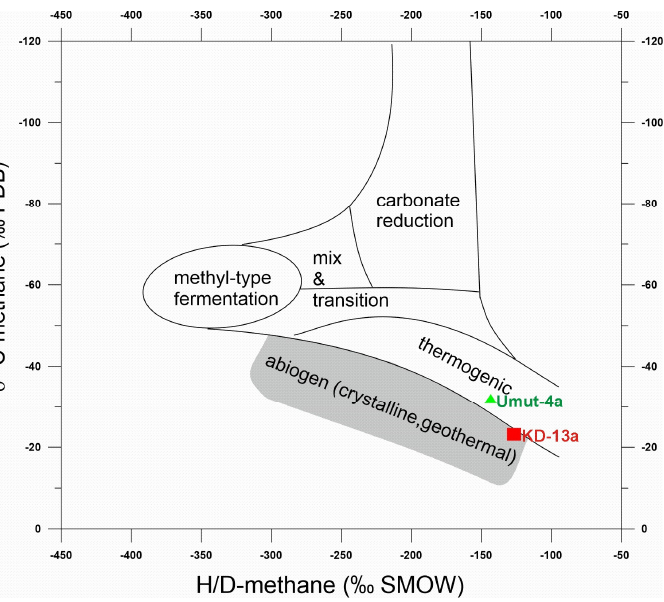
Figure 5. Diagram between δ 13 C and H/D values of methane (“Schoell-diagram”, 66). Kızıldere sample (red square) plots on the mixing line between thermogenic and abiogenic methane. Tekke Hamam sample (green triangle) in the thermogenic field.